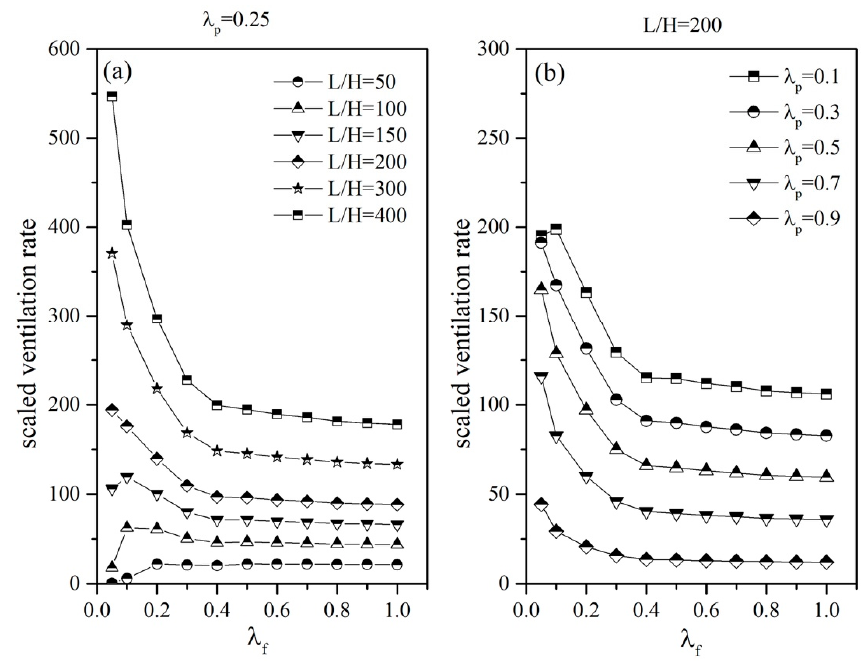
Figure 8. The total air change rate with different city length, plan area ratio ( λ p ) and frontal area ratio ( λ f ): ( a ) λ p = 0.25; and ( b ) L / H =